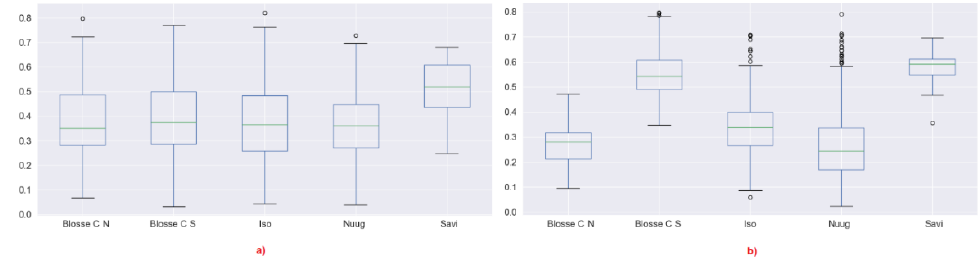
Figure 17. ( a ) Iceberg entropy, anisotropy plot 5 × 5 window, ( b ) 11 × 11 window. Colour legend indicates image. Dots indicate icebergs.